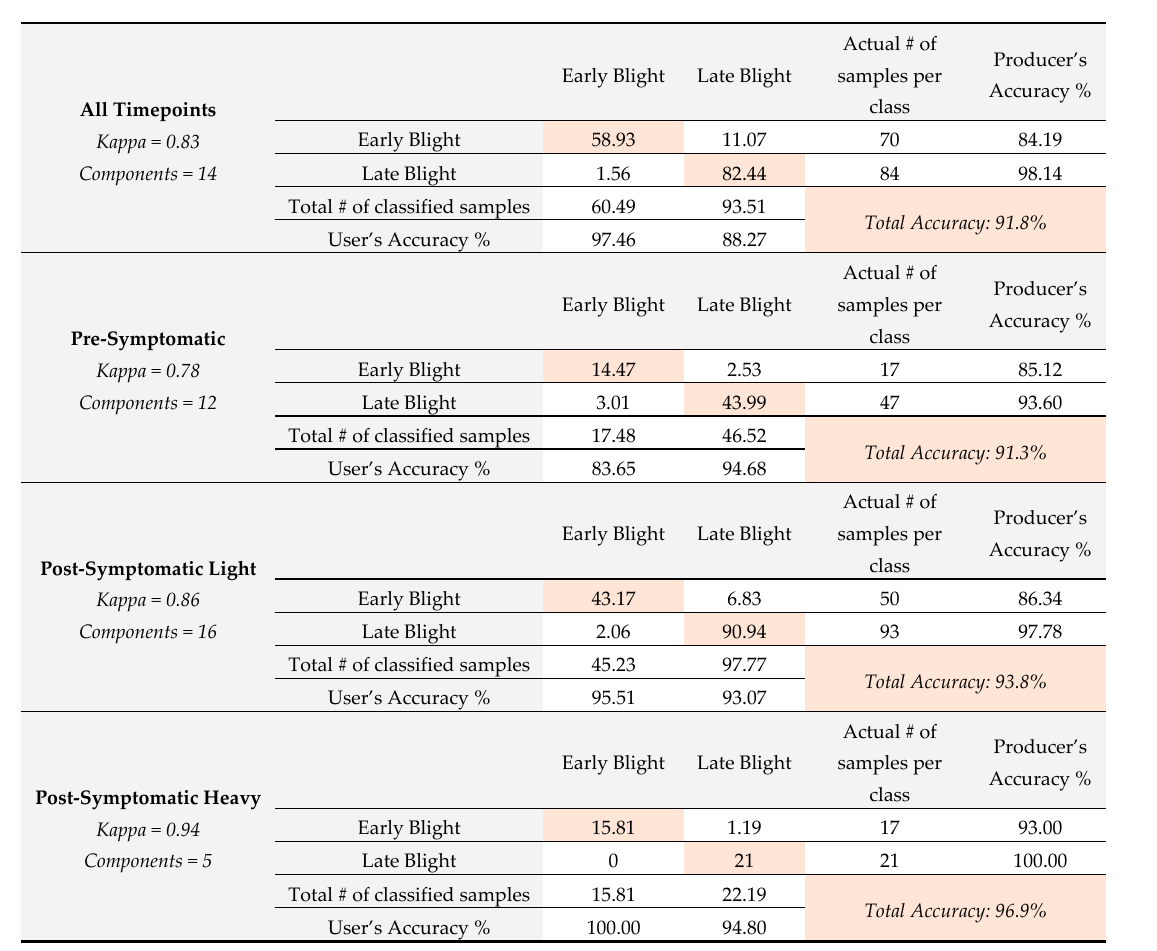
Table 3. Confusion matrices for PLS-DA internal cross-validation averages (from 100 permutations) differentiating potato late blight disease from early blight disease at all time points, pre-symptomatic time points, light infection, and heavy disease stages. Differentiation of the two pathogens is possible with greater than 90% accuracy at all time points studied.